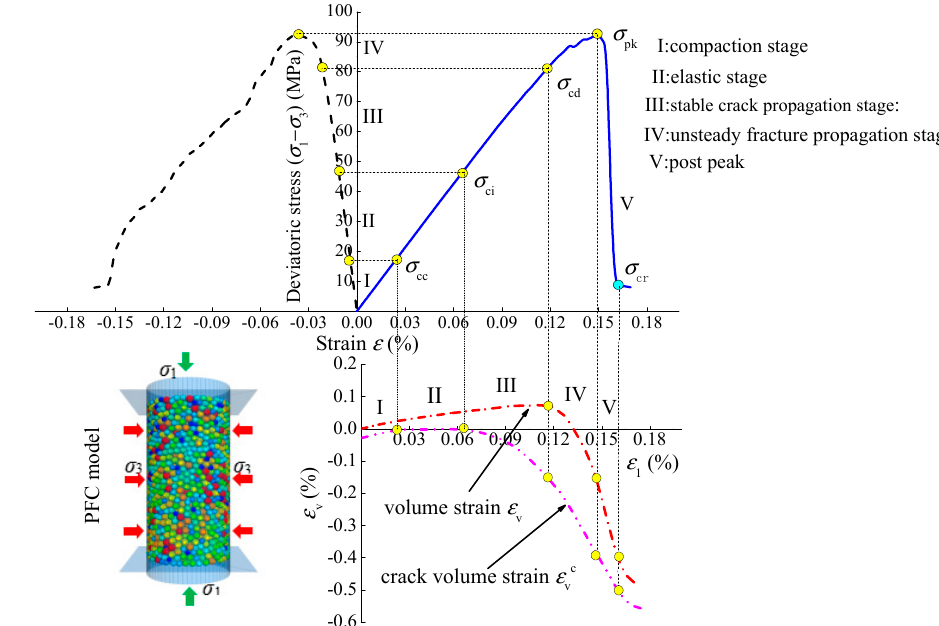
Figure 7. Curves of stress–strain, volume–strain, and crack volume–strain in the whole process of rock triaxial compression.